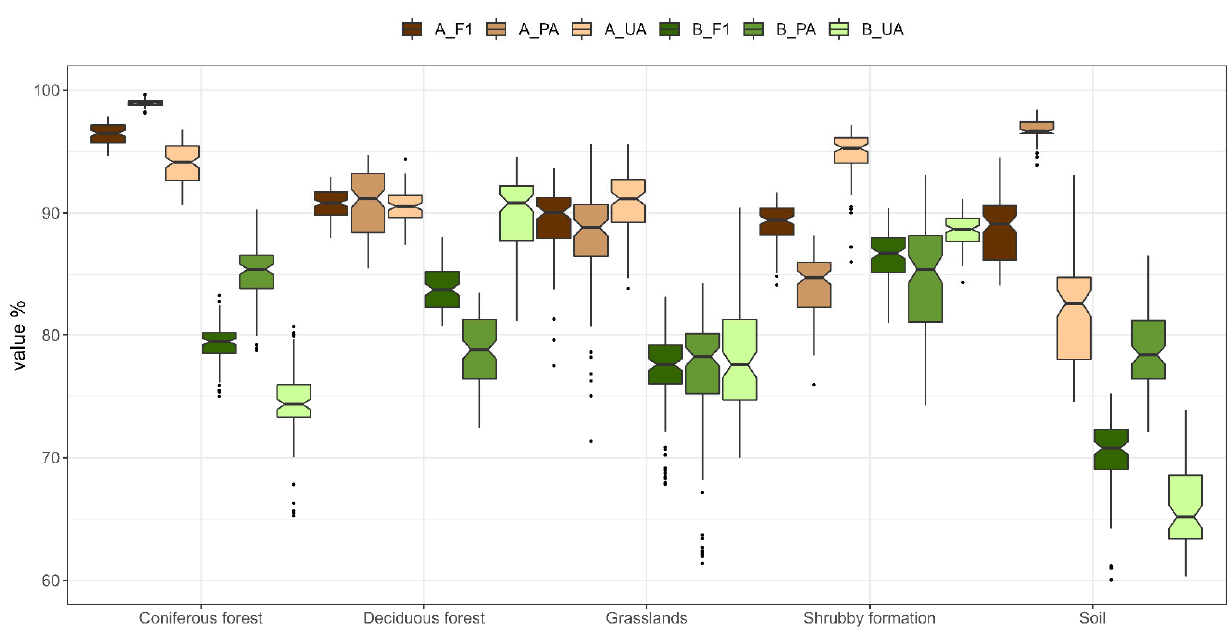
Figure 6. The result for the RF classifier for Image+CHM data set for Sentinel-2 in A and B area. F1-score; PA–Producer Accuracy; UA–User Accuracy; 100 iterations. Table 7. Confusion matrix for A and B area for each class–the RF classifier for Image+CHM data set Reference data Reference Data A